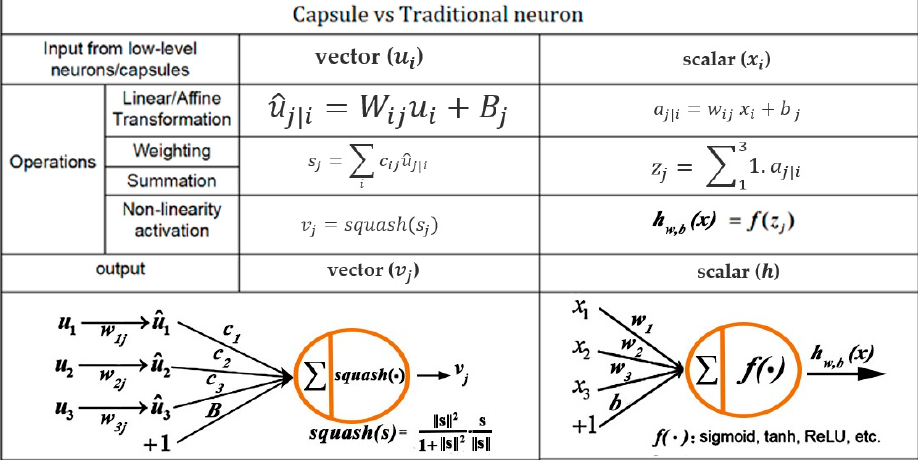
Figure 5. Comparison of capsules and traditional neurons.